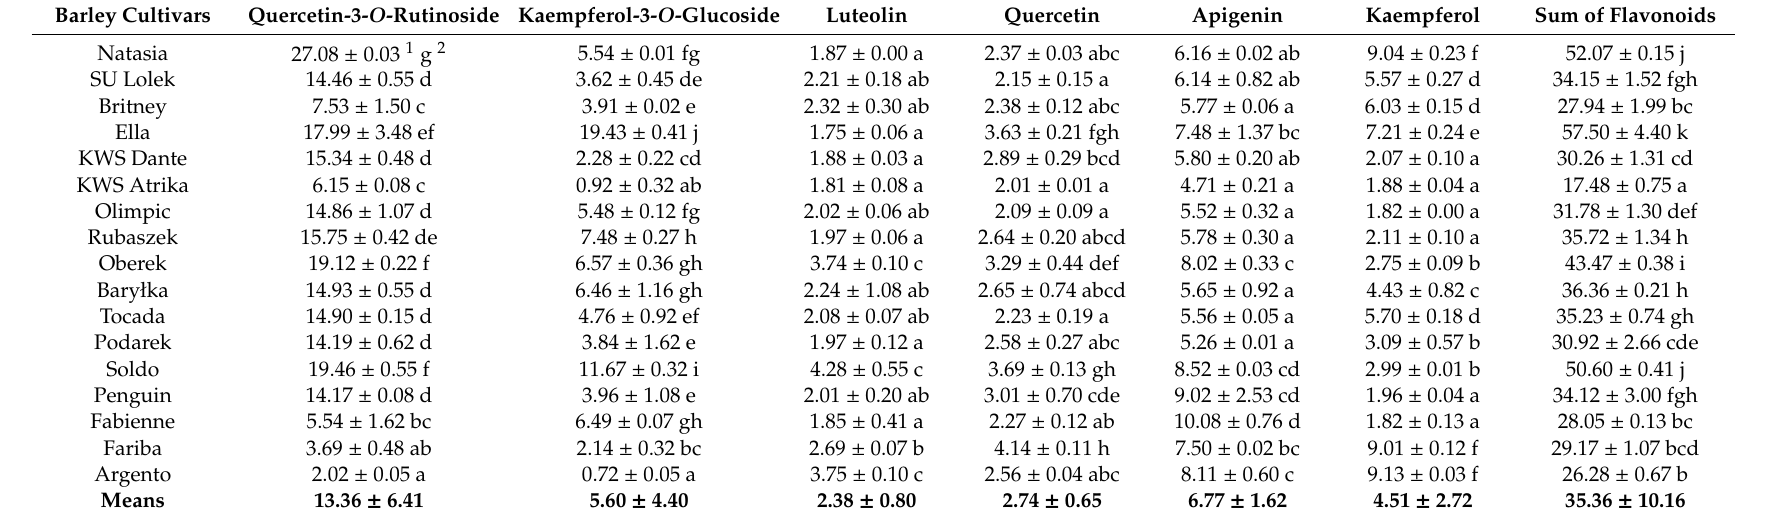
Table 4. Flavonoids concentrations (mg 100 g − 1 ) in the grain of 17 barley cultivars grown organically in the controlled field trial in Poland. Barley Cultivars